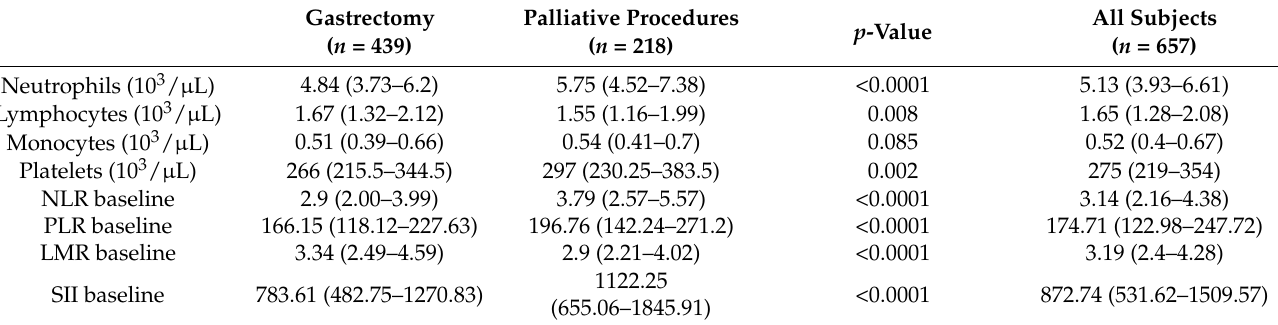
Table 2. Inflammatory biomarkers at presentation regarding treatment